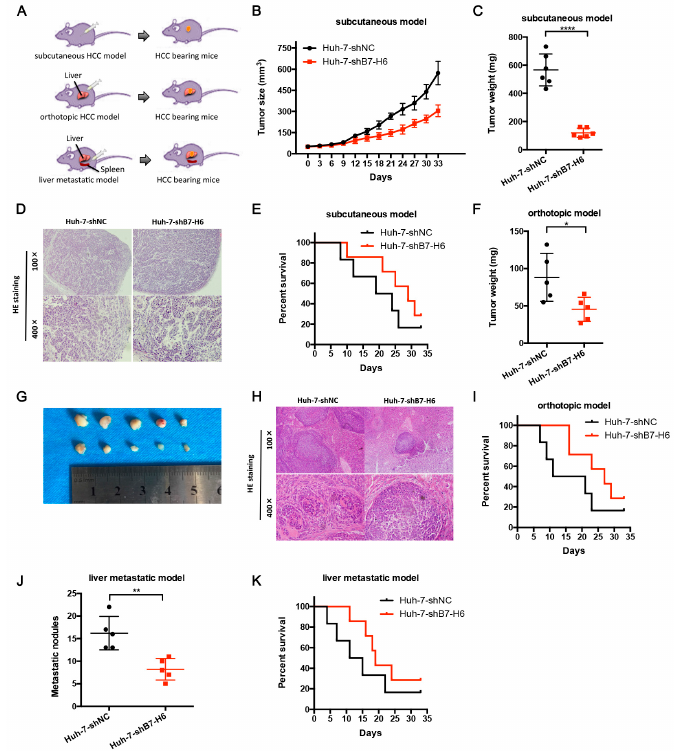
Figure 7. Knockdown of B7 ‐ H6 in HCC cells inhibits tumor growth and metastasis in vivo. ( A ) The Knockdown of B7-H6 in HCC cells inhibits tumor growth and metastasis in subcutaneous model, orthotopic model, and liver metastatic model were shown respectively. ( B , C ) Huh7 ‐ shB7 ‐ H6 and Huh ‐ 7 ‐ shNC were subcutaneously injected into the left flank of the BALB/C nude mice. Tumor size ( B ) and weight ( C ) of two groups are shown. **** p < 0.0001, Student’s t ‐ test.